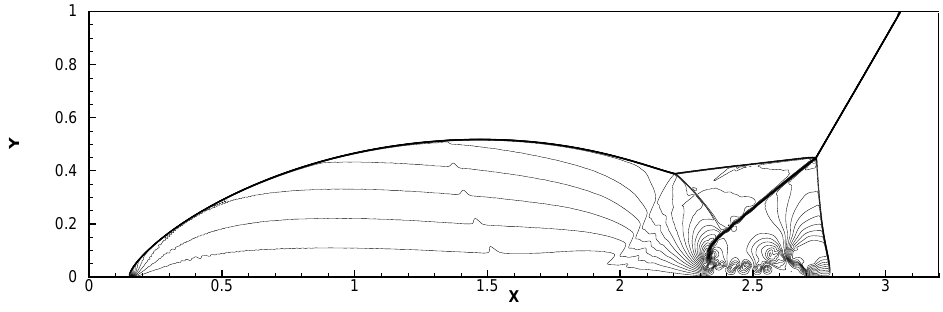
Figure 5. The two-dimensional double mach reflection problem at t = 0.2 by